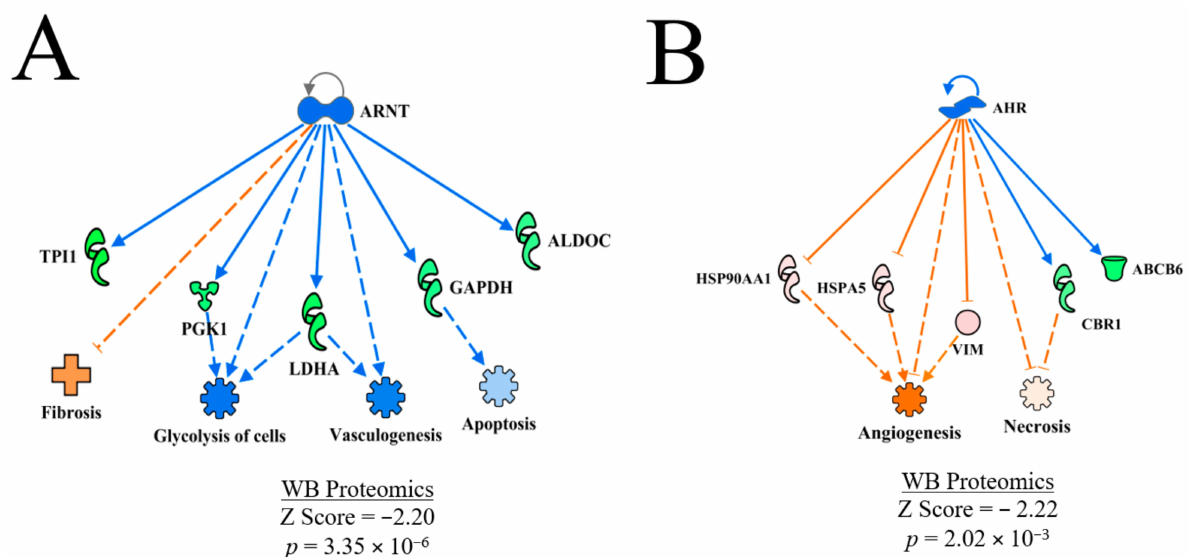
Figure 11. The upstream regulatory networks for ARNT ( A ) and AHR ( B ). The predicted inhibition of ARNT was based on the downstream expression of proteins that are shown and was associated with predicted inhibition of apoptosis, vasculogenesis and glycolysis and prediction of activation of fibrosis. Conversely, the expression of downstream target molecules of involved in predicting inhibition of AHR were associated with predictions of enhanced angiogenesis and necrosis. The discrepancy in the prediction of active necrosis in the AHR and prediction of inhibition of necrosis in the entire dataset shown in Table 2 is based on the smaller subset of expression data for AHR compared to the overall dataset. Protein abbreviations are defined and differential expression of proteins are provided in Supplementary Table